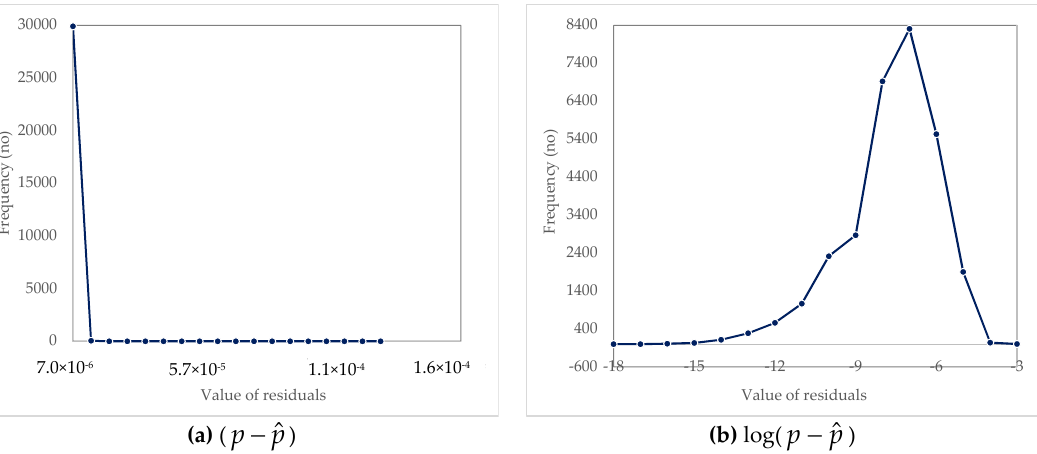
Figure 3. Distribution of residuals (differences between MC-simulated values and the values estimated by our model) for the probability from regression for the whole pool of data (30,000 pairs). ( a ) untransformed data ( b ) log transformed data A sample of p ranging from 0.500 to 0.995 with a step of 0.005 (100 values), and for n in the same